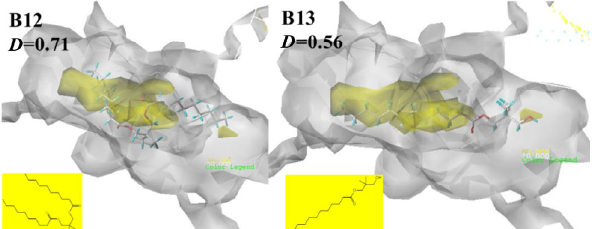
Fig. 5 CoMSIA contour diagram for hydrophobic field with embedded B12 and B13 as reference. White and yellow regions show that hydrophobic substitution is favored and disfavored, respectively.